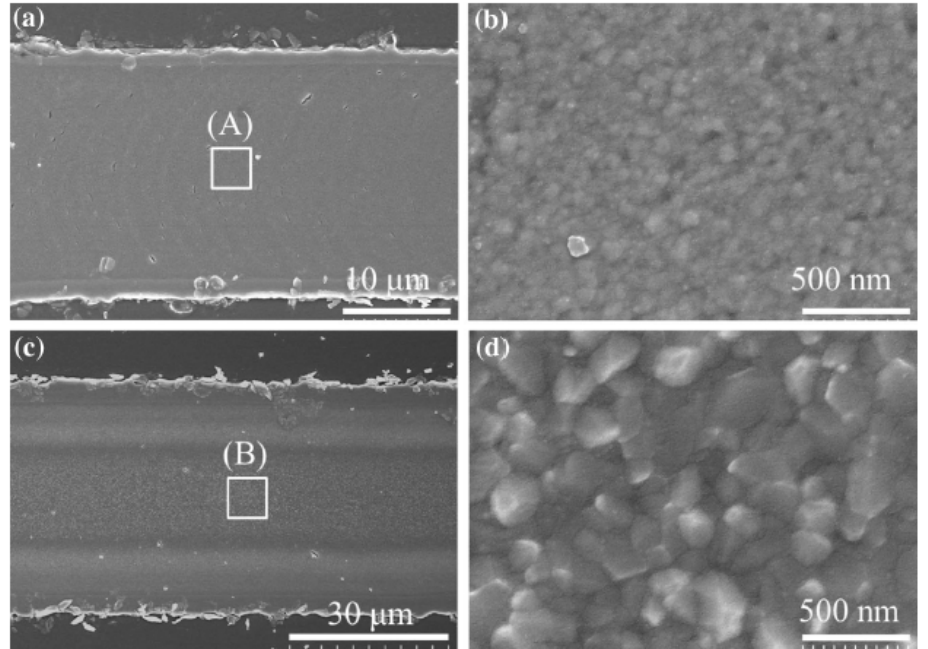
Figure 7. SEM images of Cu line patterns at a constant speed of 0.1 mm/s and laser fluences of ( a ) 12.8 mJ/cm 2 at 195 mW; ( c ) 13.8 mJ/cm 2 at 210 mW where ( b , d ) are magnified images of regions ( A ) and ( B ) (Adapted from reference [52]).